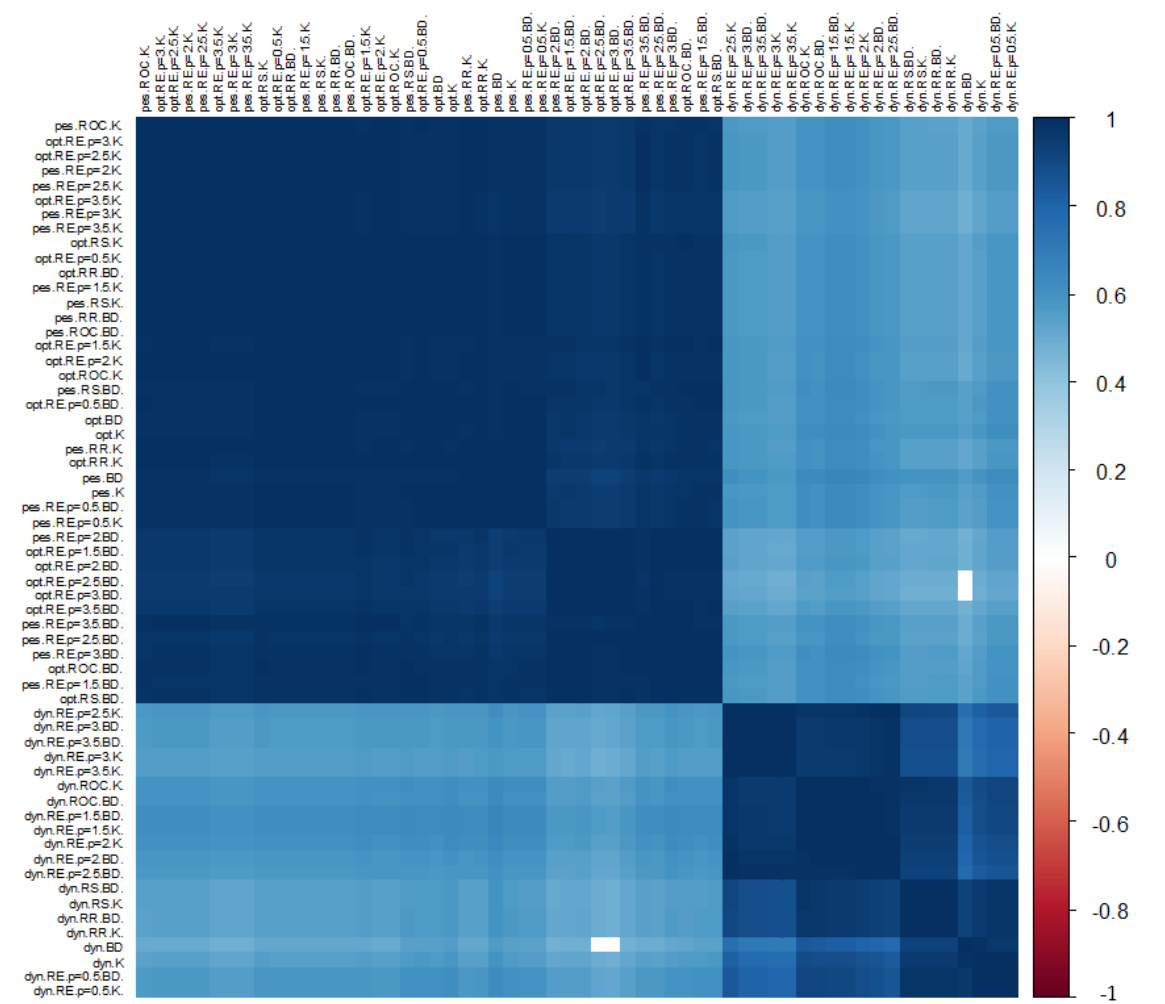
Figure 10. Illustration of the value of Spearman rank correlation coefficients for KPIs by the approaches used in the construction of indicators. Source: authors’ own material based on the GUS data.